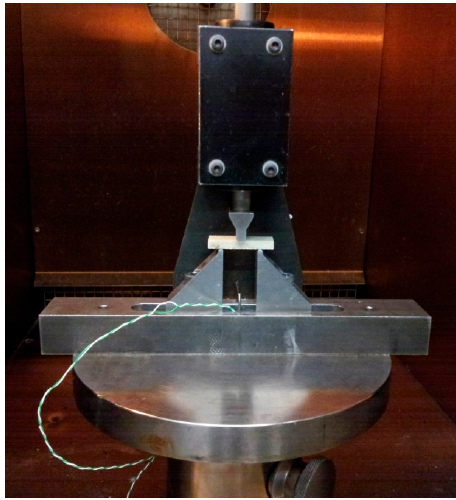
Figure 3. Short-beam shear test device.